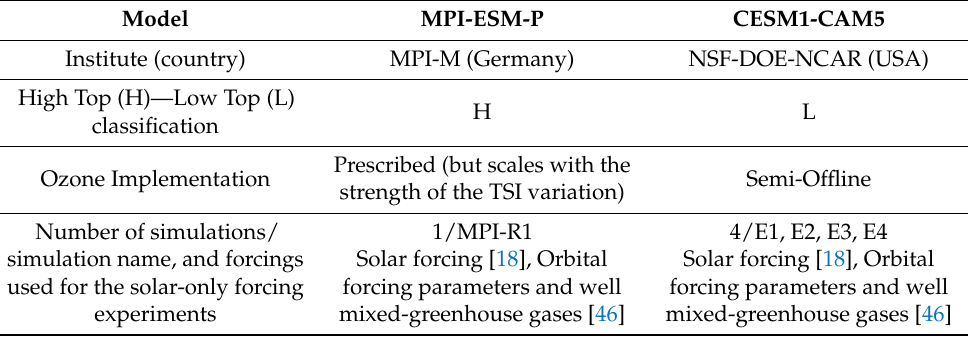
Table 1. Details on the models and experiments used in this study.